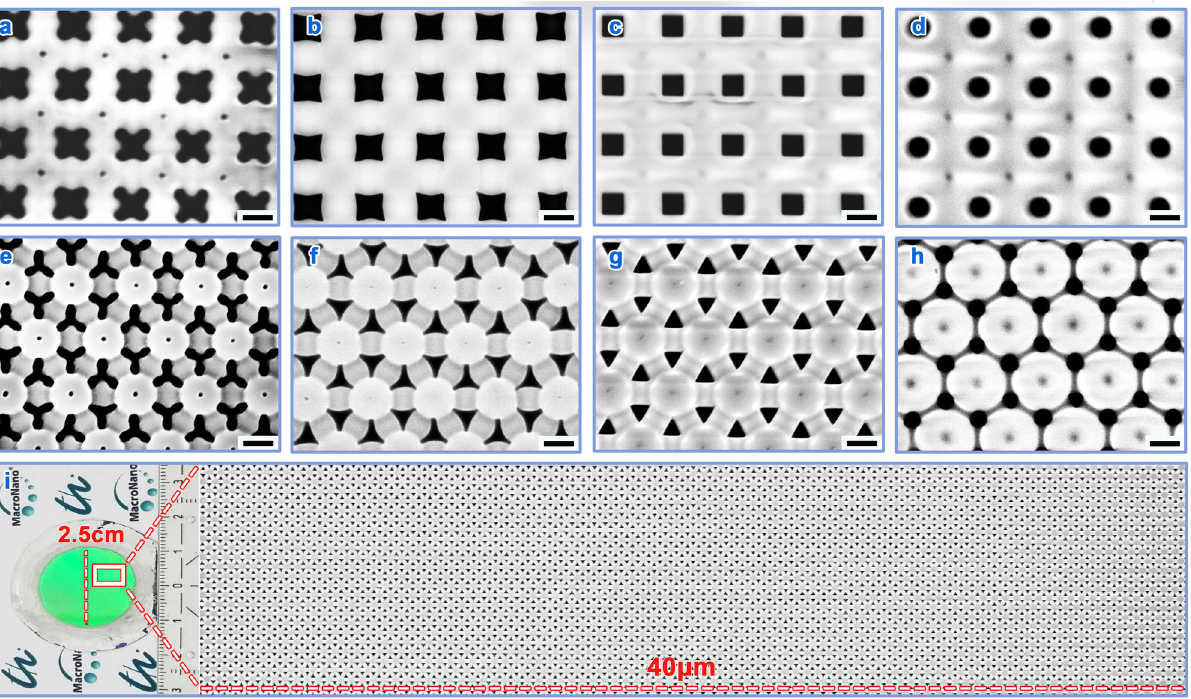
Fig. 2 Templates with in-plane shape-designable pores. SEM images of templates with shape-designable pores in a – d tetragonal and e – h hexagonal ffiffiffi p arrangements. Two arrangements are 400 and 400/ 3 nm in spacing, respectively (see Supplementary Figs. 5,11). From left to right, the exploited AVs were incrementally increased, with a 120 V, b 140 V, c 160 V, d 200 V; and e 100 V, f 120 V, g 140 V, h 155 V, respectively. i Optical photograph of 2.5-cm- diameter AAO template (left) and large-area SEM image (right). Scale bars: 200 nm.